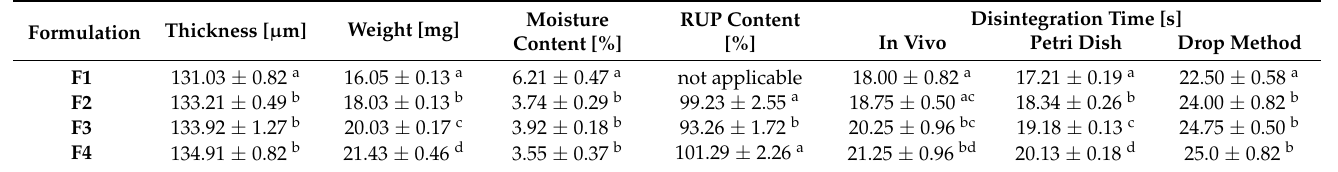
Table 3. Physicochemical characteristic of prepared ODFs ( n =